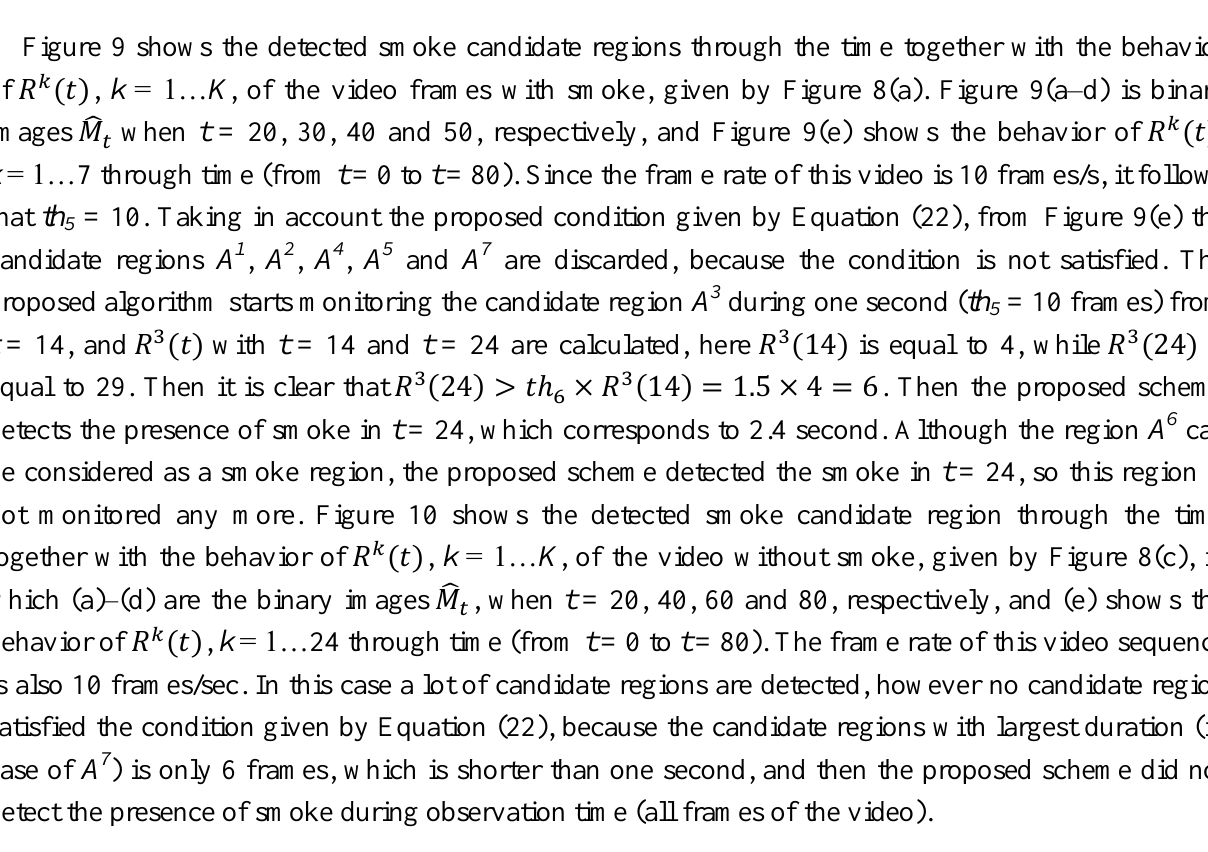
Figure 9. Behavior of , k = 1… K of a video sequences with